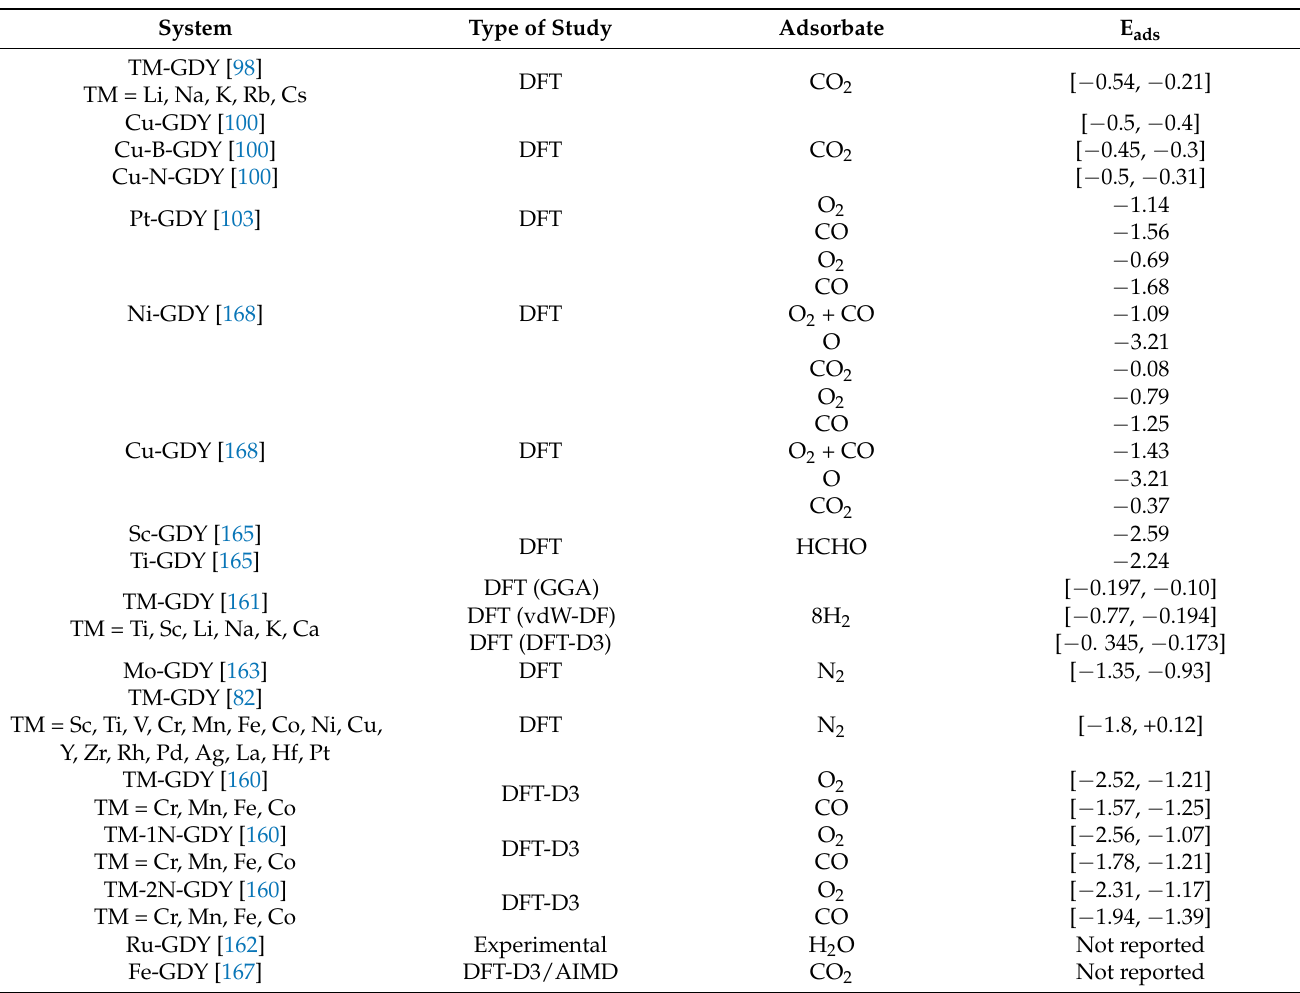
Table 10. Summary of adsorption energies E ads (in eV) for different TM-doped graphdiyne systems and adsorbates. The type of study is also